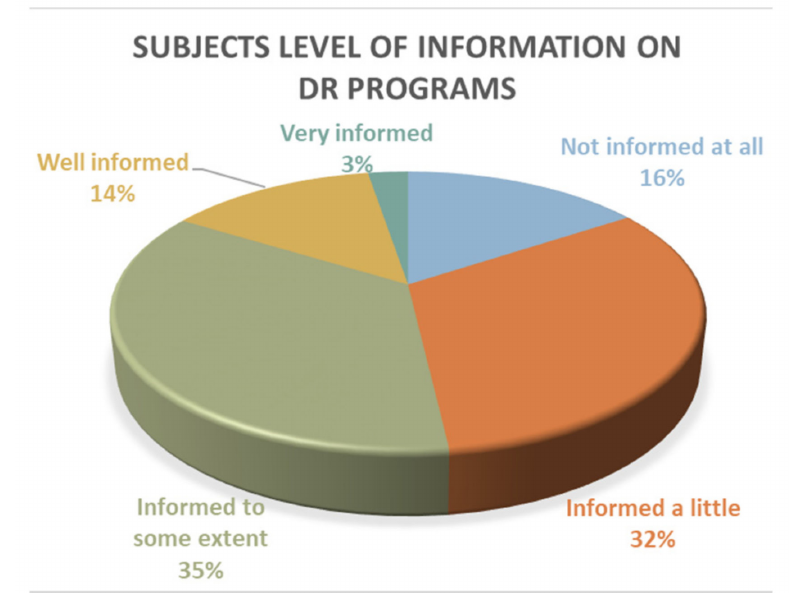
Figure 2. Consumers level of information on demand response programs. Source: Authors’ own research.